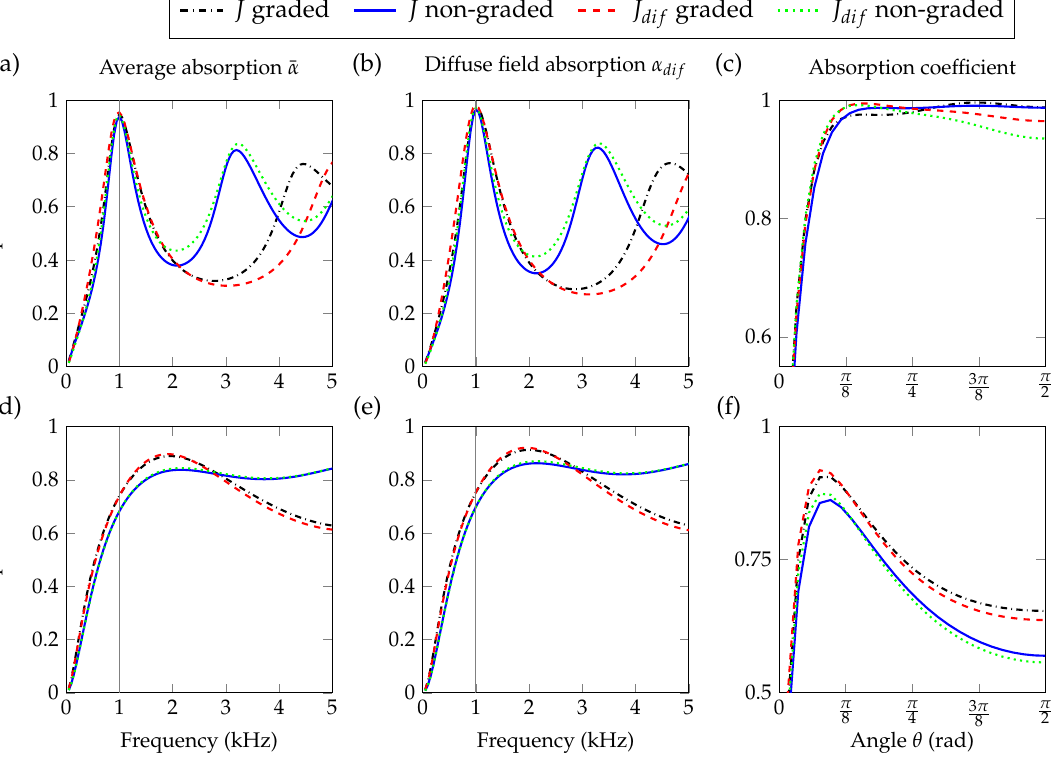
Figure 4. (Color online) Comparison of different optimization results for average and diffuse field absorption coefficients. The angular dependence of the absorption coefficient is given at the frequency f = 1000 Hz, with respect to θ . Results with anisotropic cells are given in ( a – c ), while the restriction to isotropic cells is shown in ( d – f ). In solid red and dashed blue are the results for ¯ J with N = 1 and N = 5, respectively, and for J dif with N = 1 in dashdotted green and N = 5 in dotted